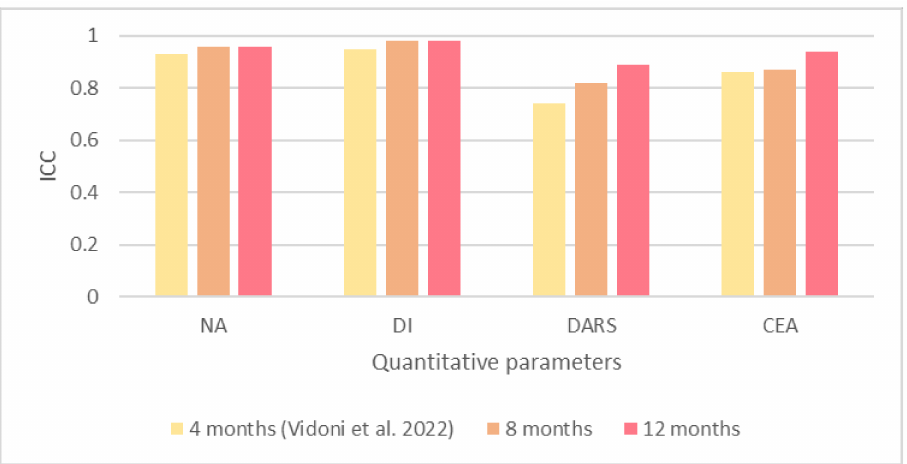
Figure 1. Illustration of intraclass correlation coefficient (ICC) of quantitative parameters at 4 [29], 8, and 12 months of